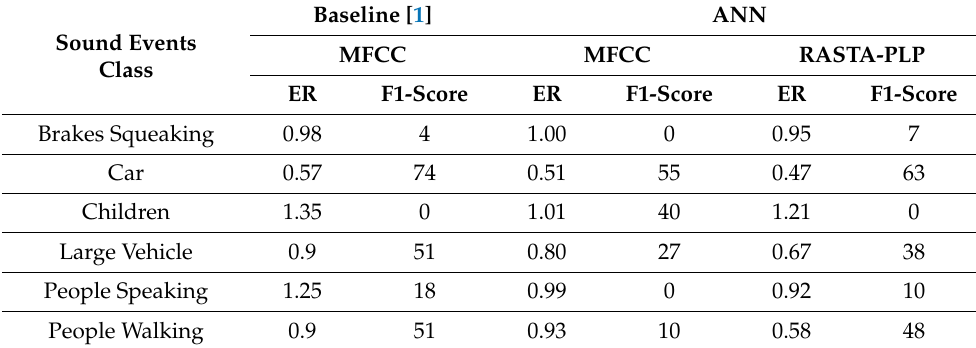
Table 4. Comparison of results using ANN classifier on